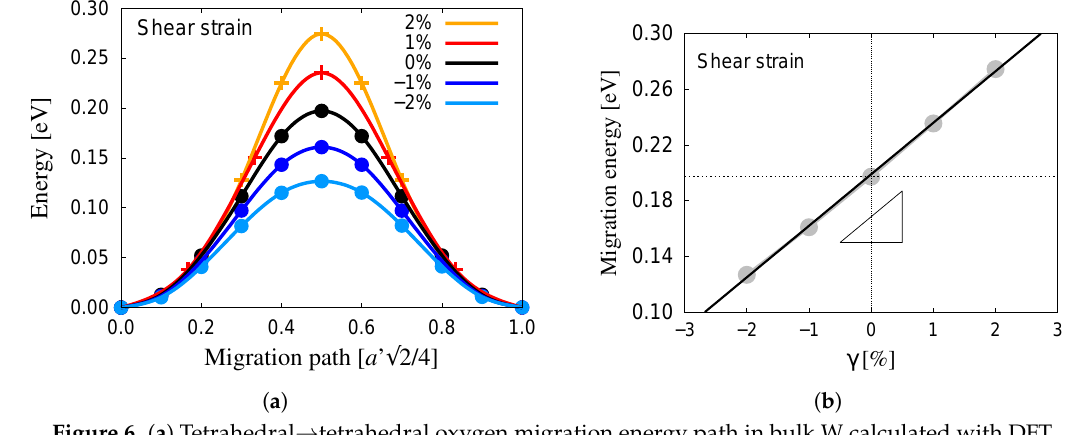
Figure 6. ( a ) Tetrahedral → tetrahedral oxygen migration energy path in bulk W calculated with DFT between two neighboring tetrahedral sites under shear strain. ( b ) Migration energy barrier under shear strain. The black line represents a least-squares linear fit, from whose slope (black triangle) the activation volume can be